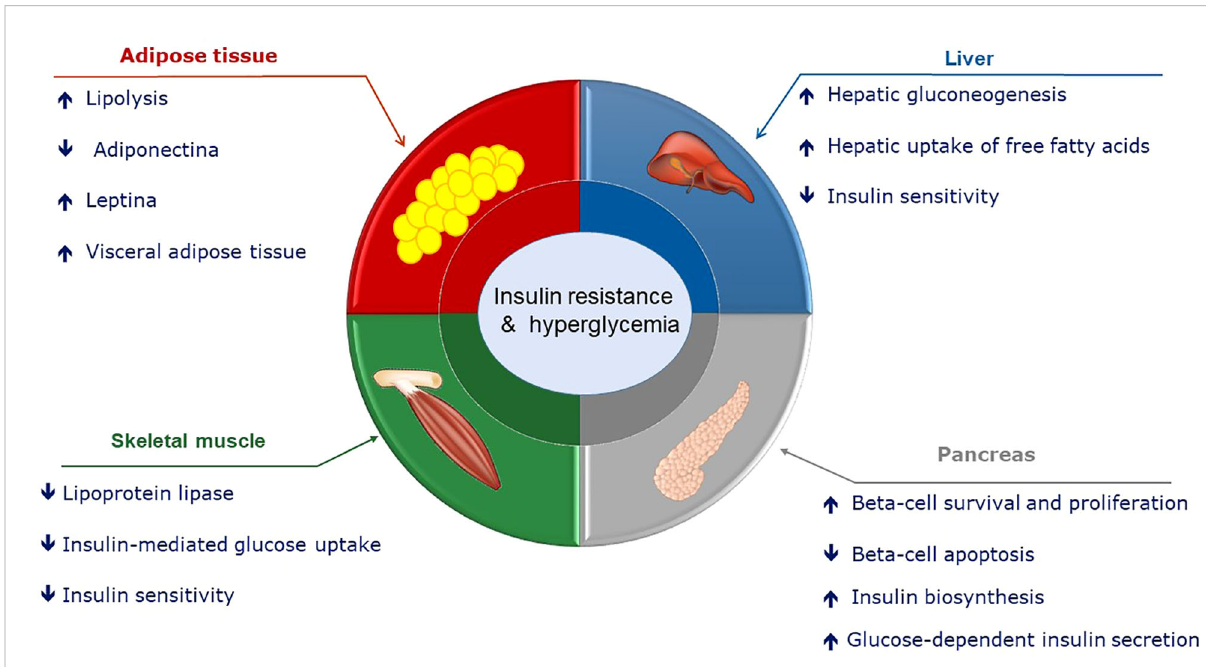
FIGURE 2 Potential role of hyperprolactinemia on glucose